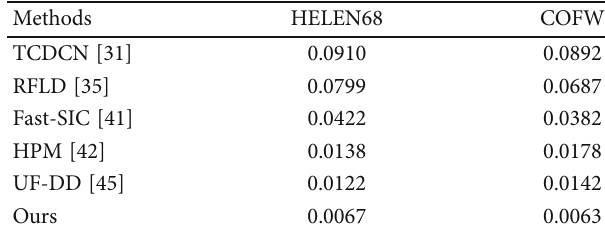
Table 2: Comparison of localization error for facial landmark